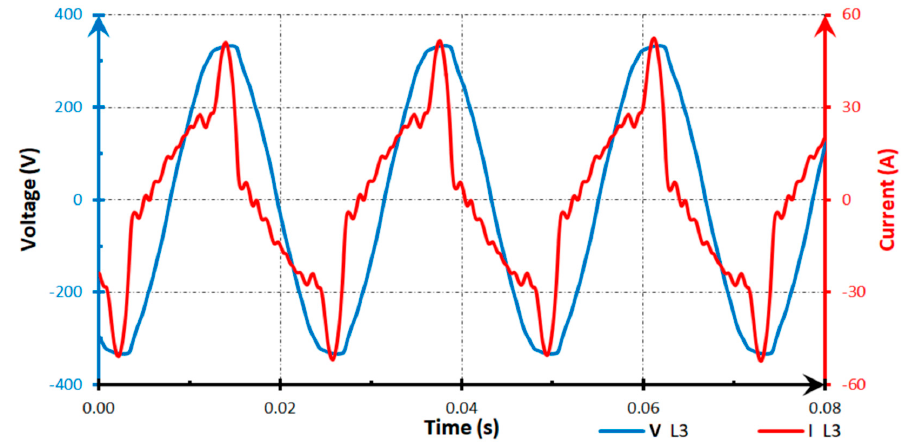
Figure 4. The course of voltage and current in the L3 phase in the monitored facility. The measurements presented above were the basis for the selection of current-compensated chokes.